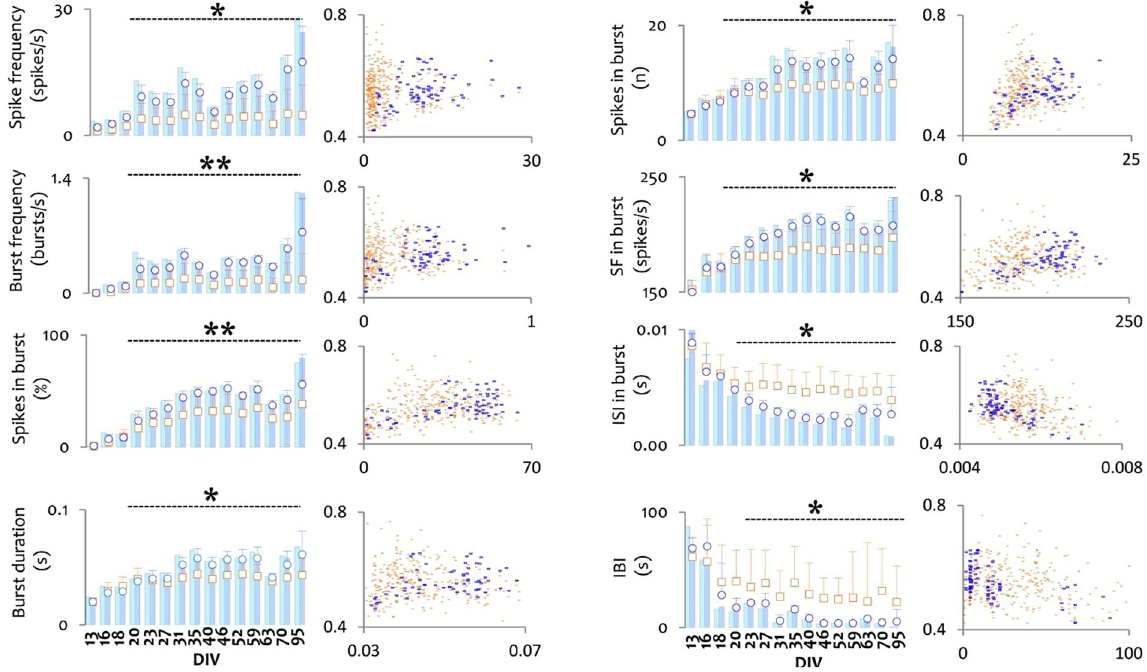
Figure 5. Axonal activity features over time and their correlation with the spike propagation velocity. Six different activity features were considered: spike frequency (spikes/s), burst frequency (bursts/s), average percentage of spikes in a burst (%), average burst duration (s), average number of spikes in a burst (n), average spike frequency in bursts (spikes/s), average inter-spike intervals in a burst (s), and average inter-burst intervals (s). Bar graphs: two blue bars (light blue and dark blue) at each recording DIV represent the average of a specific feature recorded from a narrow and a wide microchannel of one culture. For each DIV, blue circles represent the average of a variable across 6 microchannels of one culture (n = 90 data points), orange circles the average over 7 cultures (n = 42 microchannels and n = 630 data points). Data are represented as mean ± StDev. Scatter plots: correlation analysis between each feature and the signal propagation velocity on data collected over three months from all cultures (brown dots: > 400 data points) and one exemplary culture (blue dots). For each microchannel, the signal feature (x) and propagation velocity (y) was averaged over a 15 min recording window for each recording day to result in one data point (orange or blue dots). ISI: inter-spike intervals in a burst, IBI: inter-burst intervals. * p < 0.05 and ** p < 0.01 vs . DIV 13–18 values (repeated measure ANOVA). P values and details on the correlation analysis are summarized in Suppl. Table